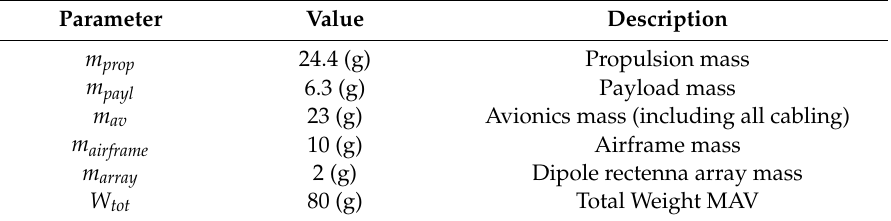
Table 1. Estimated weights of propulsion, payload and avionics